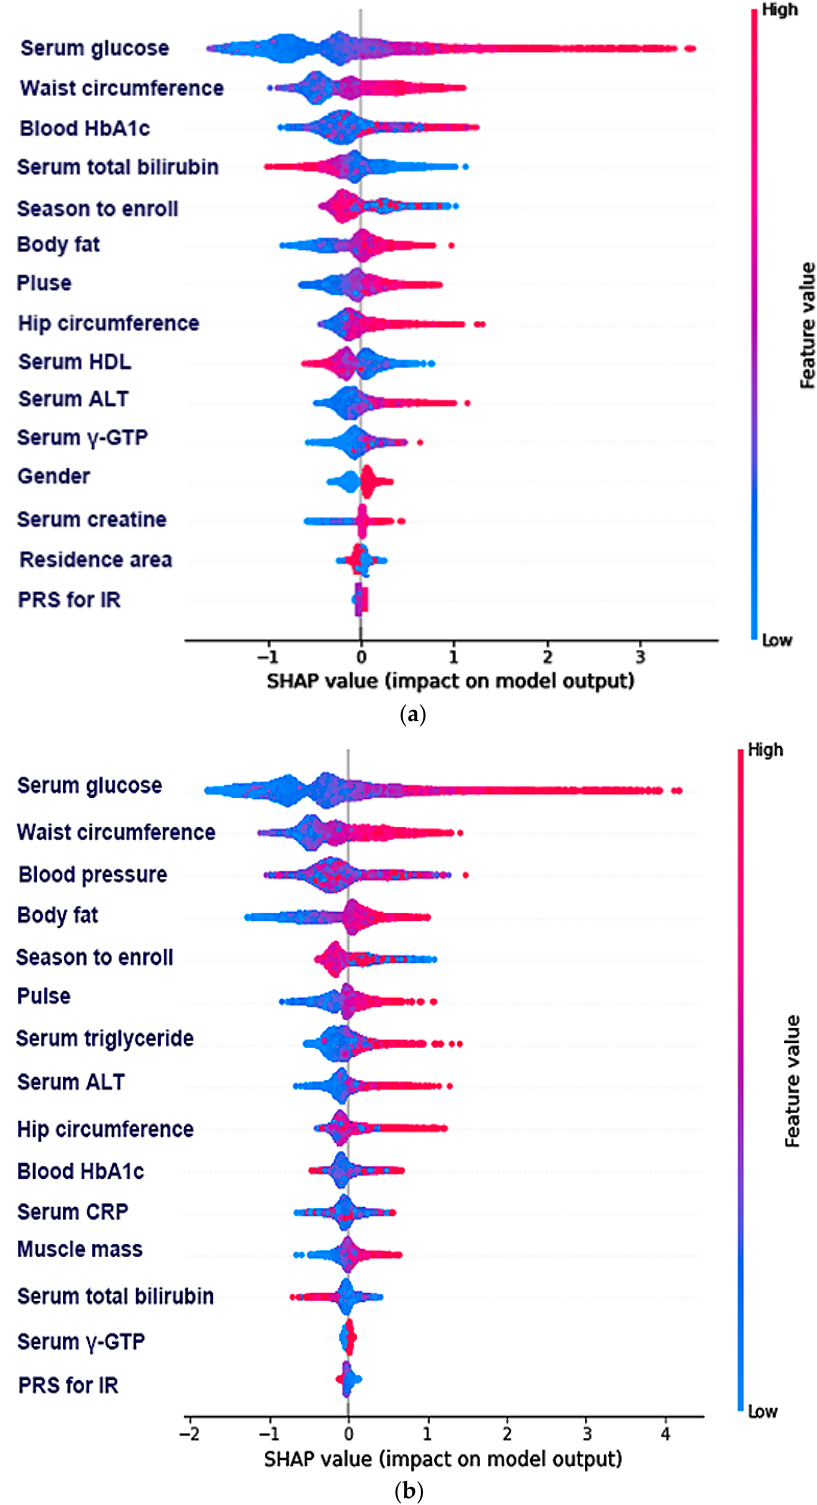
Figure 4. Positive and negative impact explanation of the top 15 features for predicting insulin resistance (IR) using SHAP values. ( a ) Explanation of each feature impact on the IR in the prediction model by the SHAP values in the XGBoost algorithm. ( b ) Explanation of each feature impact on the IR in the prediction model by the SHAP values in random forest algorithm. ALT, alanine aminotransferase; HbA1c, hemoglobin A1c; γ -GTP, γ -glutamyl transpeptidase; HDL, high-density lipoprotein; CRP, high-sensitive C-reactive protein; PRS, polygenetic risk scores. The nine feature models from XGBoost and random forest algorithms were the same. The model included the fasting serum glucose, ALT, total bilirubin, HDL concentrations, waist circumference, body fat, pulse, season to participate, and gender (Figure 5A, 5B). On the other hand, the relative importance of the selected features was different between the XGBoost and random forest algorithms (Figure 5A, 5B). SHAP shows the association of each feature to predict insulin resistance (Figure 5C).